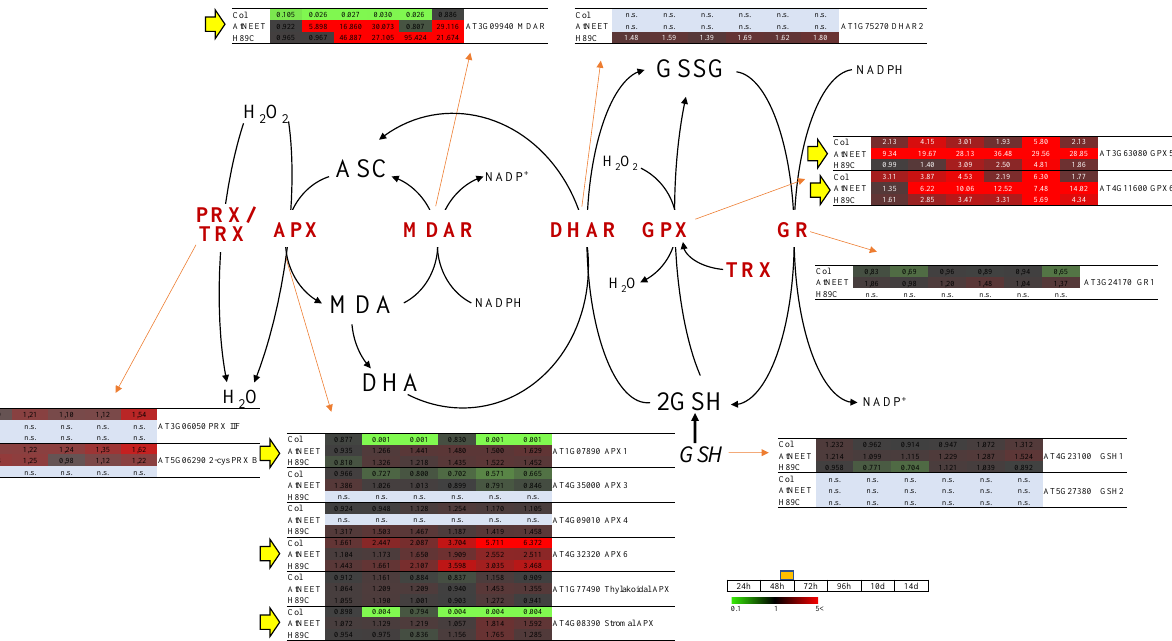
Figure 8. Changes in protein expression associated with reactive oxygen species (ROS) scavenging during the course of the experiment. Pathway and heat maps for the expression of different proteins with a significant change in expression (in at least one time point, compared to time 0 h within each genotype) associated with ROS scavenging in Arabidopsis at the different time points are shown. Yellow arrows highlight proteins of interest at the different points. All experiments were repeated at least three times with similar results. Abbreviations used: APX, ascorbate peroxidase; ASC, ascorbate; DHA, dehydroascorbate; DHAR, dehydroascorbate reductase; GPX, glutathione peroxidases; GR, glutathione reductase; GSH, glutathione; GSH1, glutamate-cysteine ligase 1; GSH2, glutathione synthase 2; GSSG, oxidized glutathione; MDA, monodehydroascorbate; MDAR, monodehydroascorbate reductase; n.s., not significant; PRX; peroxiredoxin; TRX, thioredoxin.